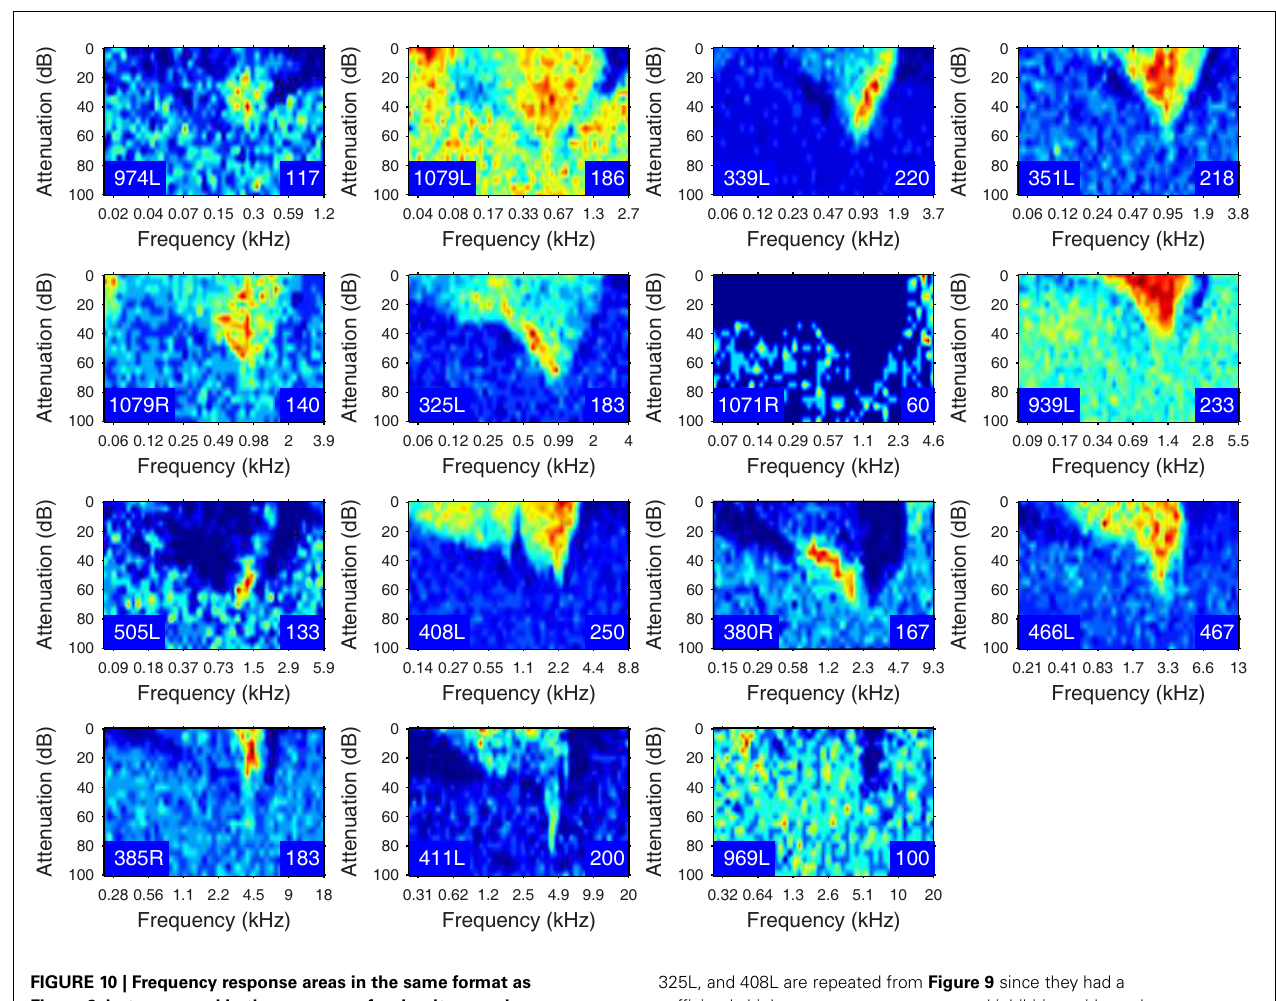
FIGURE 10 | Frequency response areas in the same format as Figure 8, but measured in the presence of a simultaneously presented CF tone at 10dB above minimum threshold. Units 351L,